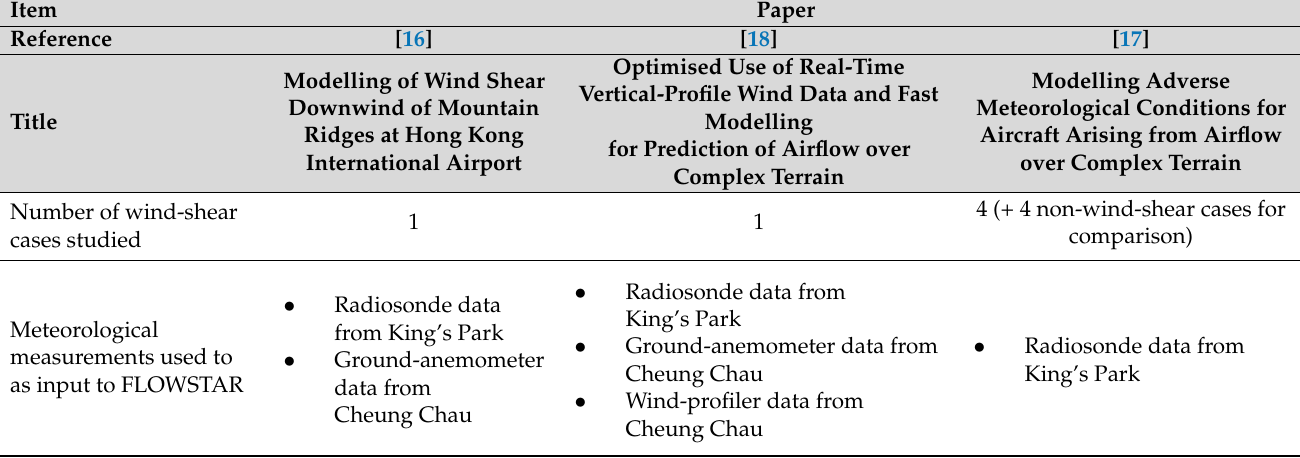
Table 1. Summary of previous HKIA wind-shear modelling studies using FLOWSTAR, listing meteorological measurements used for model input and evaluation, and sensitivity